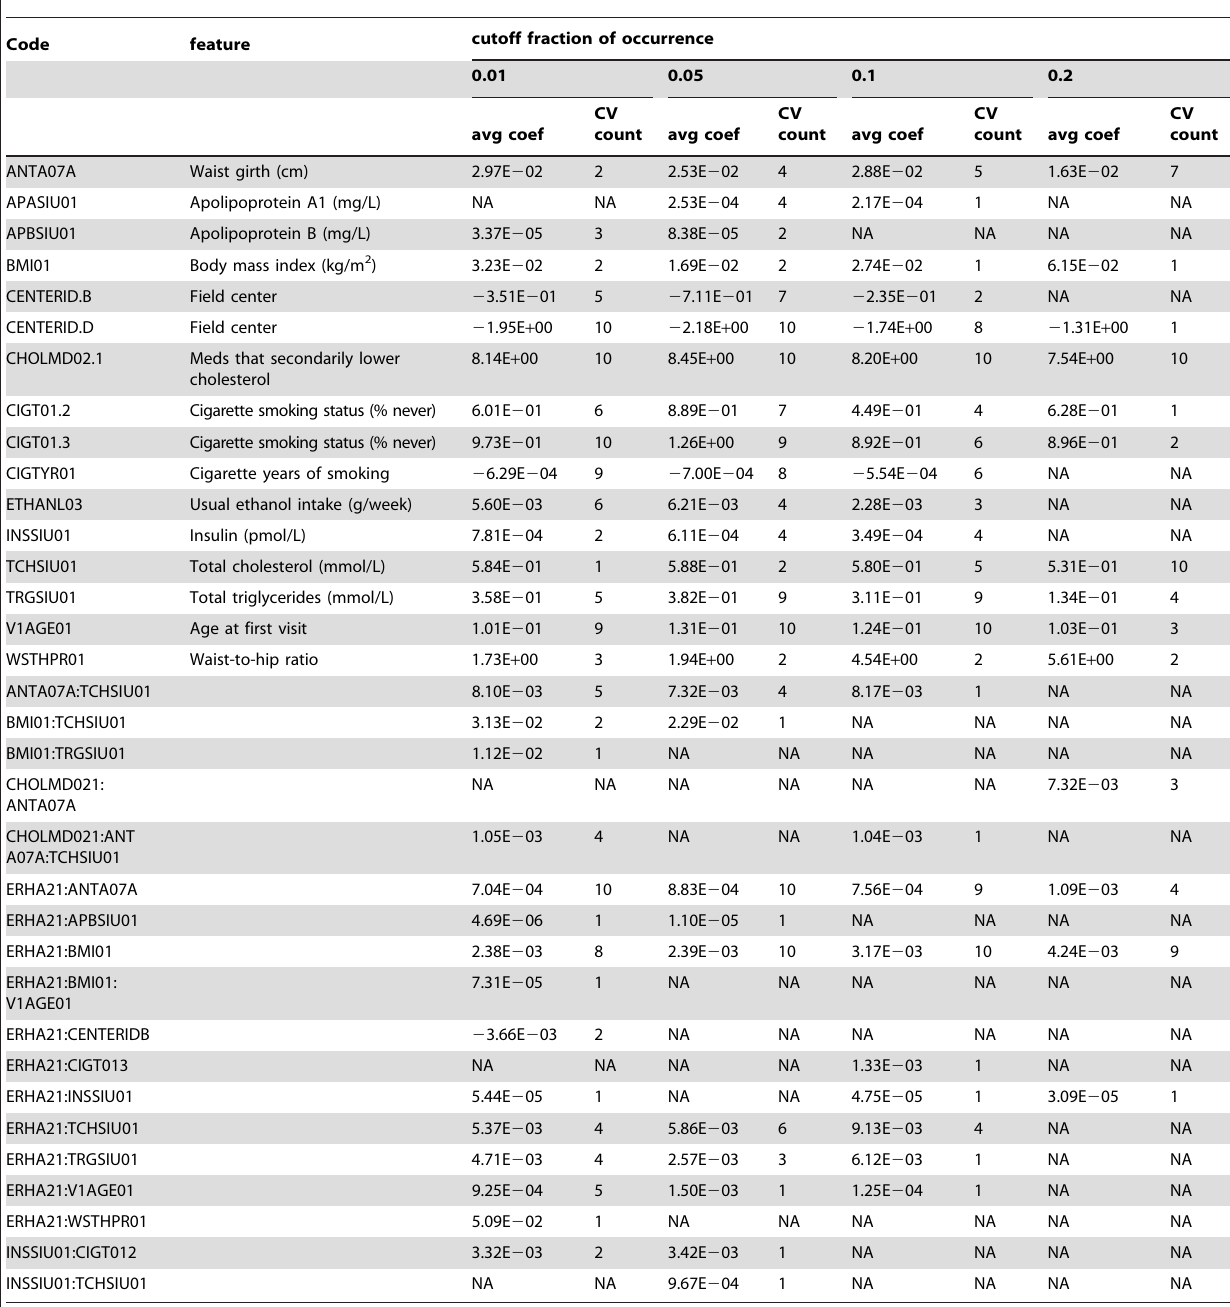
Table 1. Non-SNP features (above the horizontal line) and interactions (below the horizontal line) chosen by our adaptive prediction